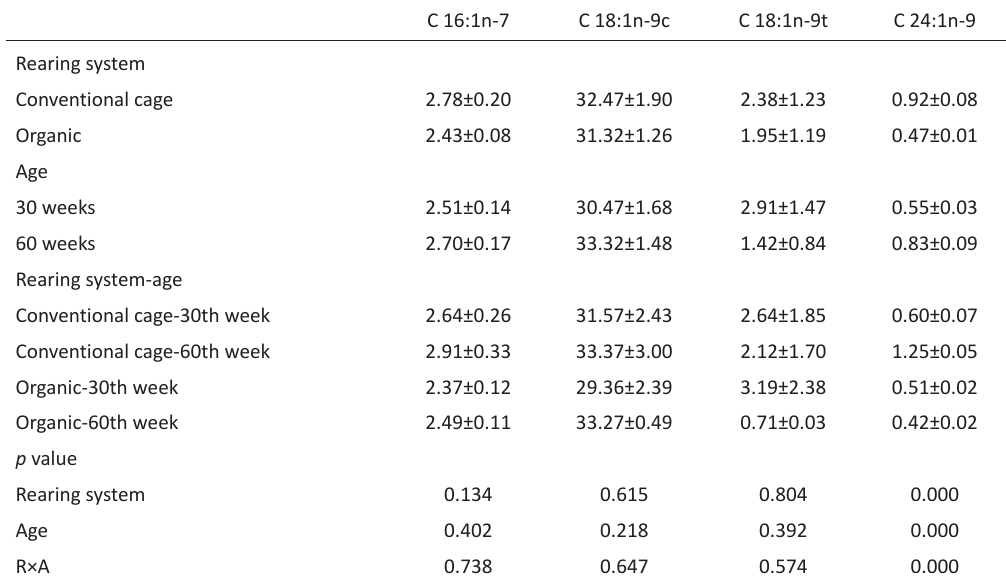
Table 5. Levels of monounsaturated fatty acids in the egg yolks (%)